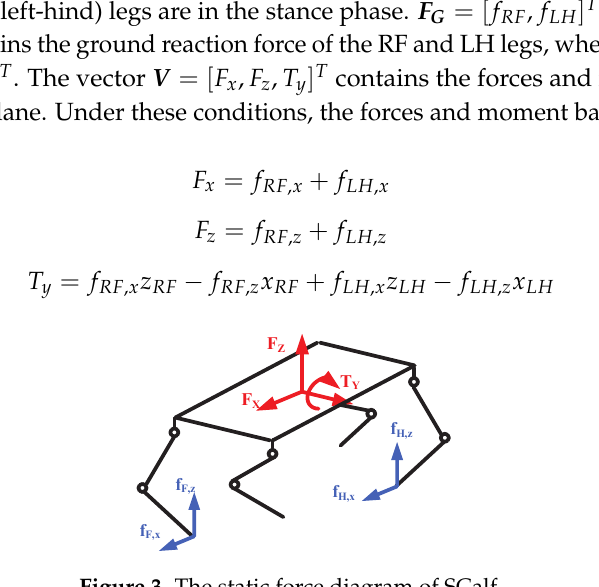
Figure 3. The static force diagram of